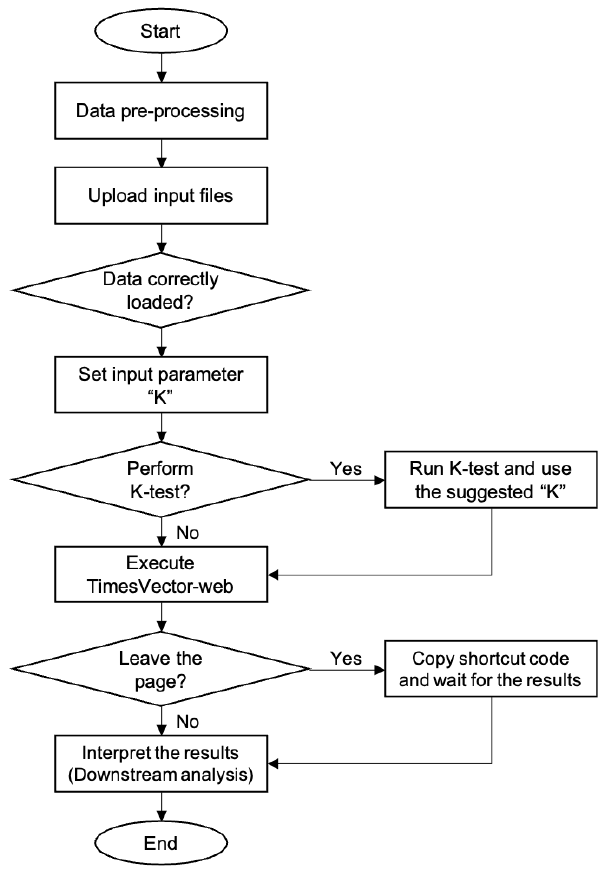
Figure 1. The workflow of